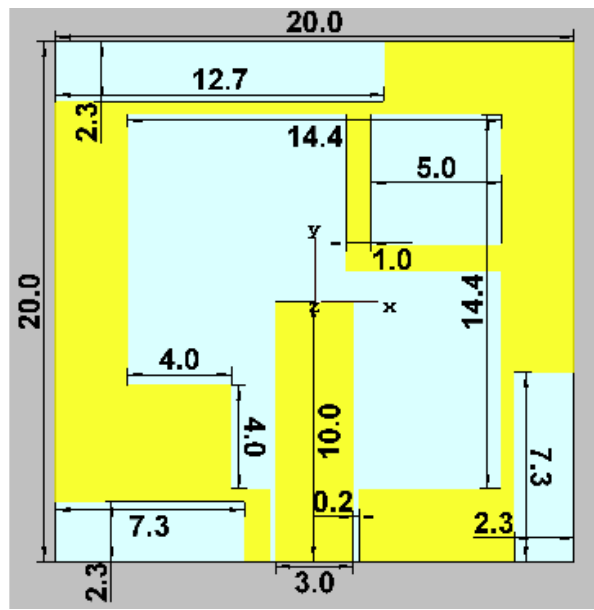
Fig. 2. Sketch of the offered CPW-fed square slot antenna (in mm). Table I represents all the notations used in design along with their